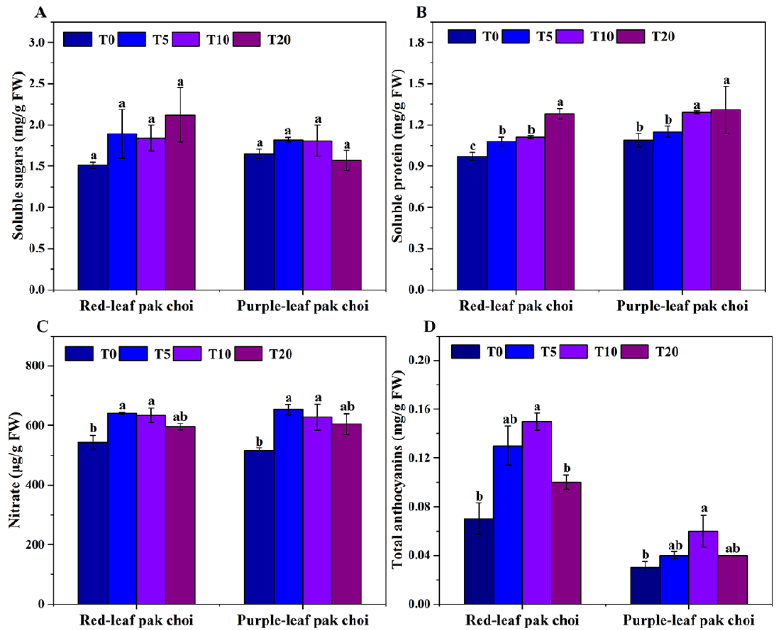
Figure 5. Effects of blue and UVA light on the soluble sugars ( A ), soluble protein ( B ), nitrate ( C ) and total anthocyanins ( D ) of red- and purple-leaf pak choi. T0, T5, T10 and T20 mean 0 UVA with 50 B, 5 UVA with 45 B, 10 UVA with 40 B and 20 UVA with 30 B (μmol·m − 2 ·s − 1 ), respectively. Different letters mean statistical differences determined with Duncan’s multiple test at p < 0.05 among treatments. Error bars indicate ± SE ( n = 3).